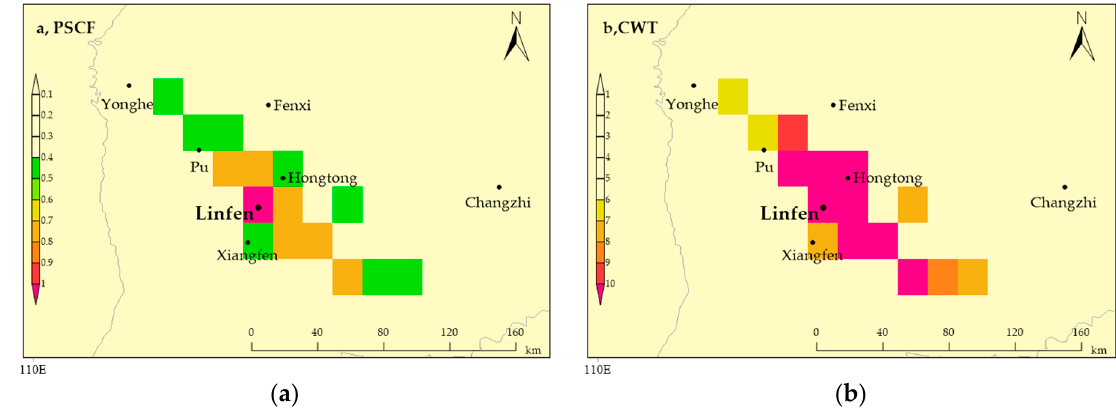
Figure 7. The map of potential source regions for carbonyls ( a ) and the distribution of weighted trajectory concentrations ( b ) in urban Linfen from 16 to 25 January 2019.